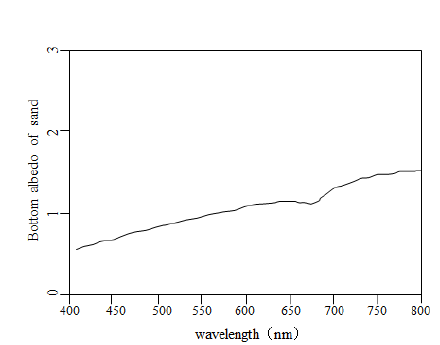
Figure3 550-nm normalized bottom albedo spectrum